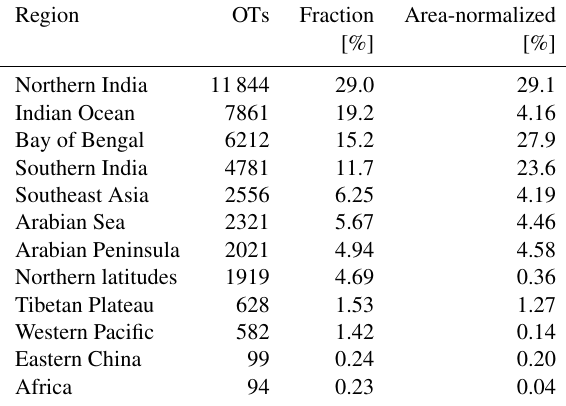
Table 1. Summary of the regional distribution of cross-tropopause convection including the total number of OTs observed throughout the entire study period, the percentage of total OTs, and the area- normalized percent contribution for each